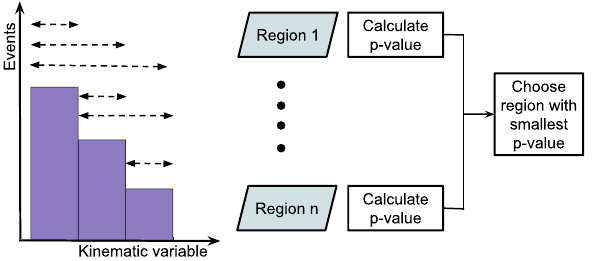
Fig. 2 Illustration for the calculation of p values in different regions and the selection of the RoI as the region with the smallest p value. The dashed lines with arrowheads represent the different possible continu- ous combinations of bins that are referred to as